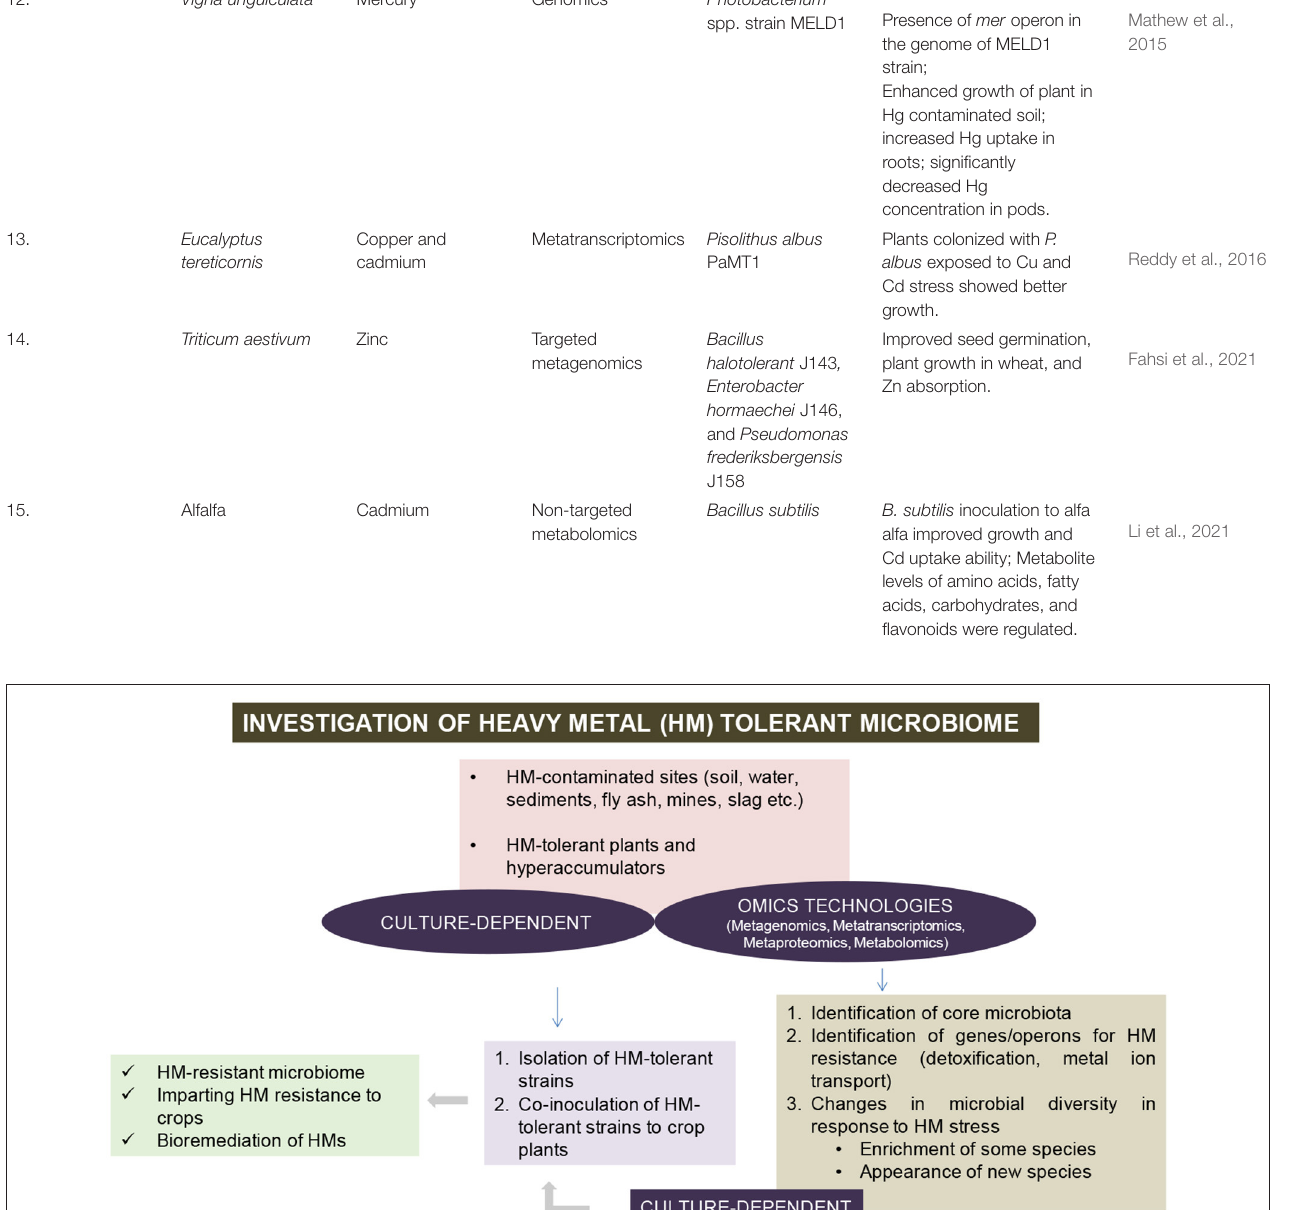
cost-effective technique, 16S rRNA gene sequencing has been widely used for taxonomic profiling of microbial communities associated with HM-contaminated soil samples. For example, a study involving 16S rRNA gene sequencing of two nickel contaminated sites in southwest Slovakia revealed that